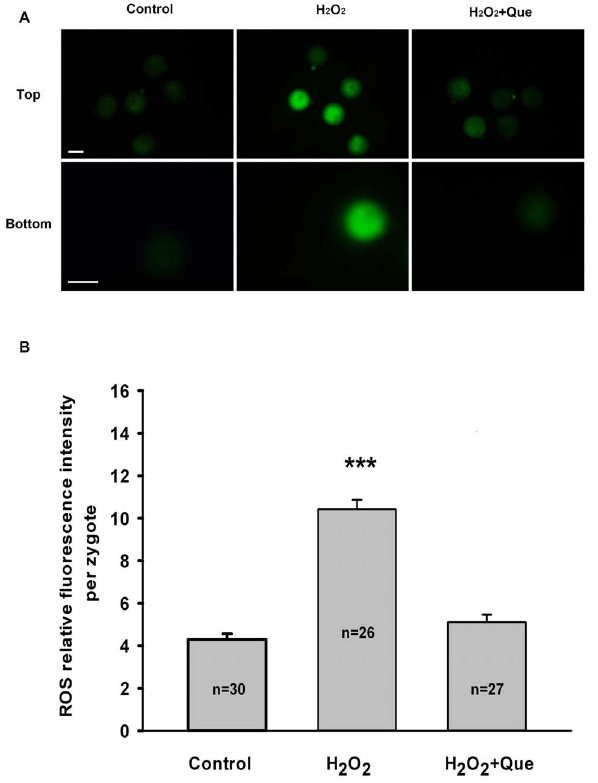
Figure 3. Quercetin decreases H 2 O 2 -induced intracellular ROS level in mouse zygotes. (A) Representative images of ROS levels in zygotes treated with H 2 O 2 or H 2 O 2 plus Que. The lower panels of images represent a magnified view of one zygote from the upper panels. Intracellular ROS were measured by the DCFH fluorescence (Green). Bar, 50 m m. (B) Quantification of relative fluorescence intensity of ROS per zygote. Data are presented as the mean 6 SEM from three independent experiments. N shows the number of zygotes. *** P , 0.001, compared with the control group (One-way ANOVA).